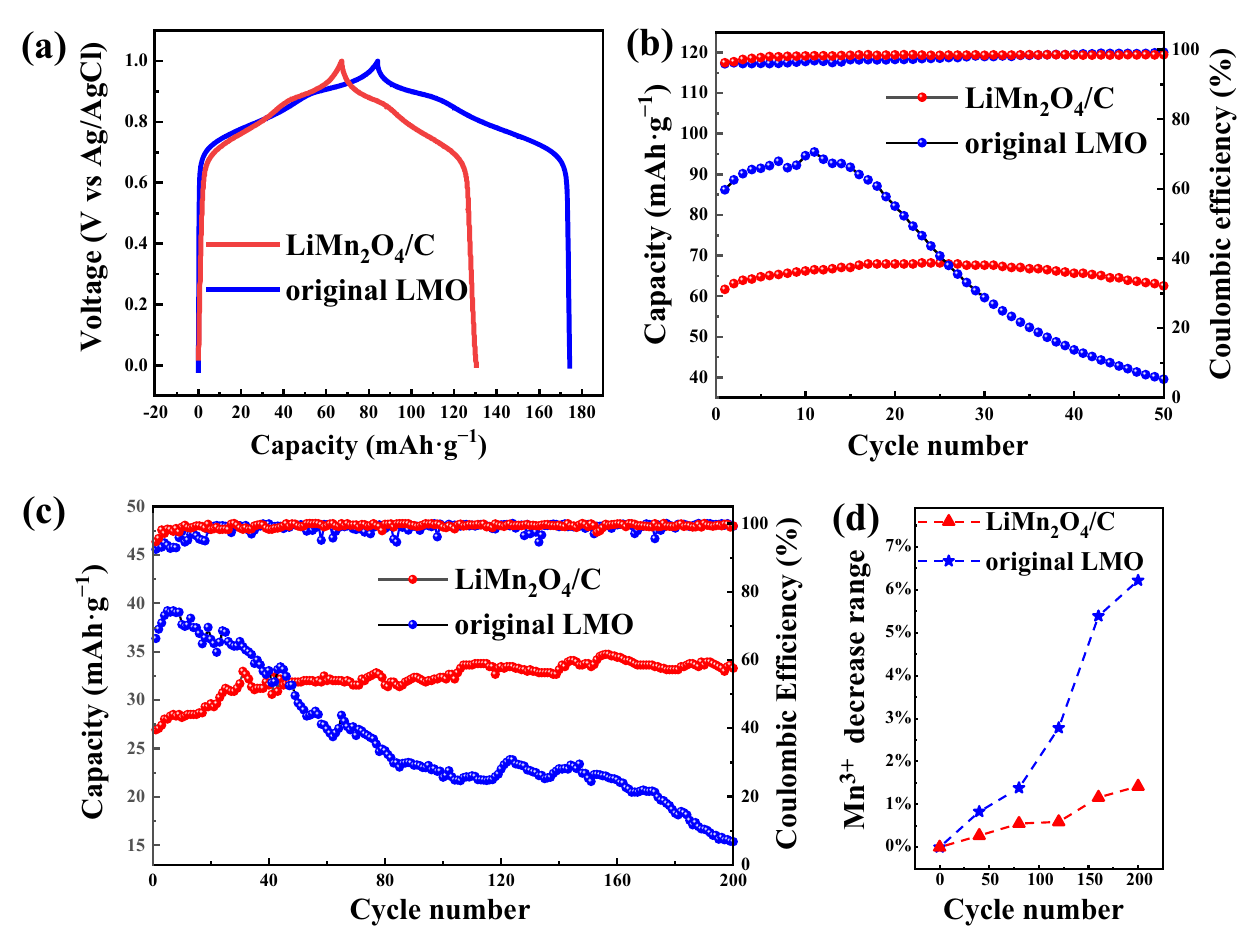
Fig. 2 a Galvanostatic charge–discharge (GCD) profiles of LiMn 2 O 4 /C and bulk LMO in 1.0 M LiCl solution. Cycling performances of the two materials in b 1.0 M and c 10 mM LiCl solutions. d Mn 3+ content decreases during the cycling tests in 10 mM LiCl